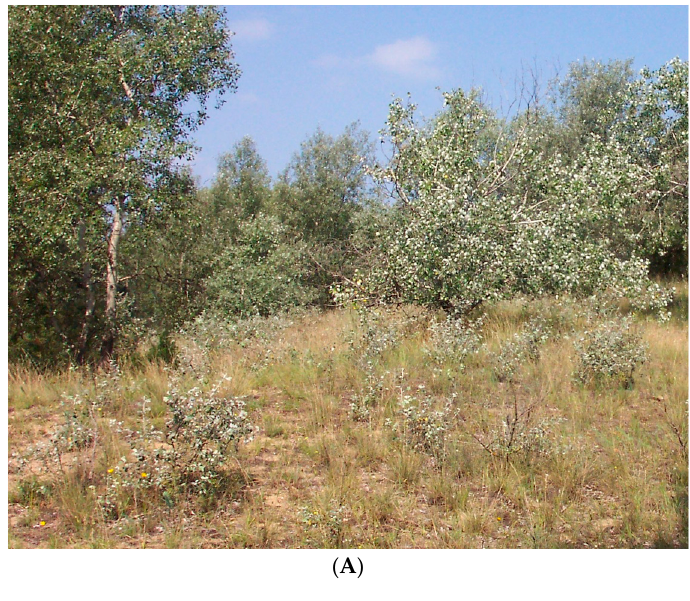
Figure A1. ( A ) Location of the study sites showed by the red and black dots for the Hungarian and Italian sites, respectively; the map is taken from Metzger et al. 2005; ( B ) Walther–Lieth diagrams of the long-term temperature and precipitation data (1901–2015, data from monthly CRU TS v.4.00, KNMI Climate Explorer http://climexp.knmi.nl, resolution 0.5 °C) for the Hungarian site (upper panel) and Italian site (lower panel).